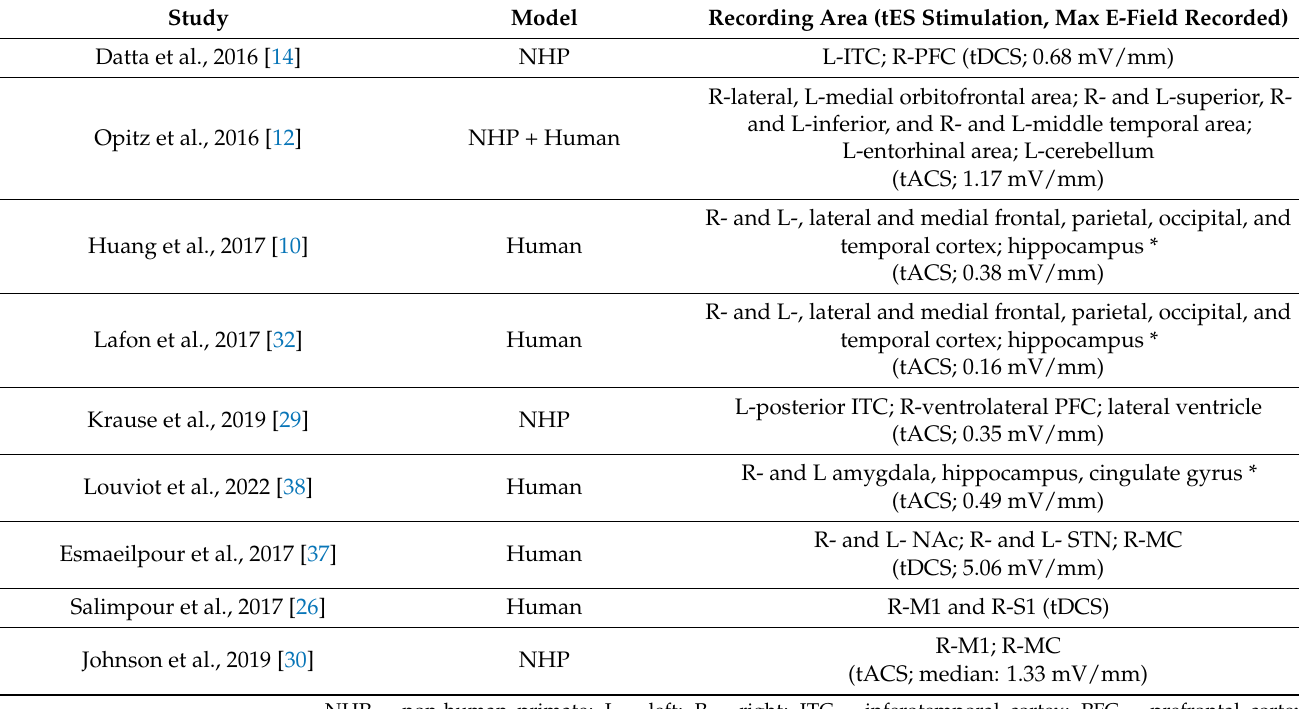
Table 2. Studies investigating electric fields in right hemisphere structures.